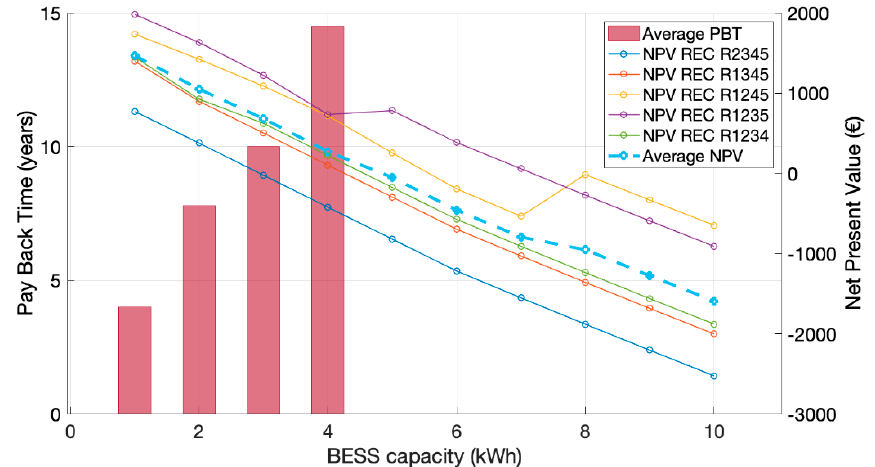
Figure 12. NPV (line chart) and PBT (bar chart) for BESS investment in the “BESS, MILP” scenario. The light blue, dashed line refers to the averaged NPV across all the REC configurations, while the solid lines refer to the NPV for one of the five specific REC configuration analyzed.